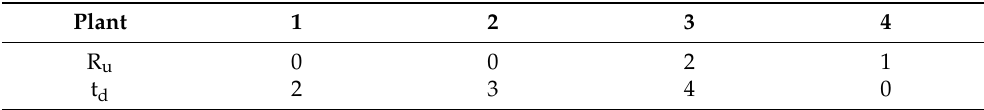
Table 4. Water flow lag data.